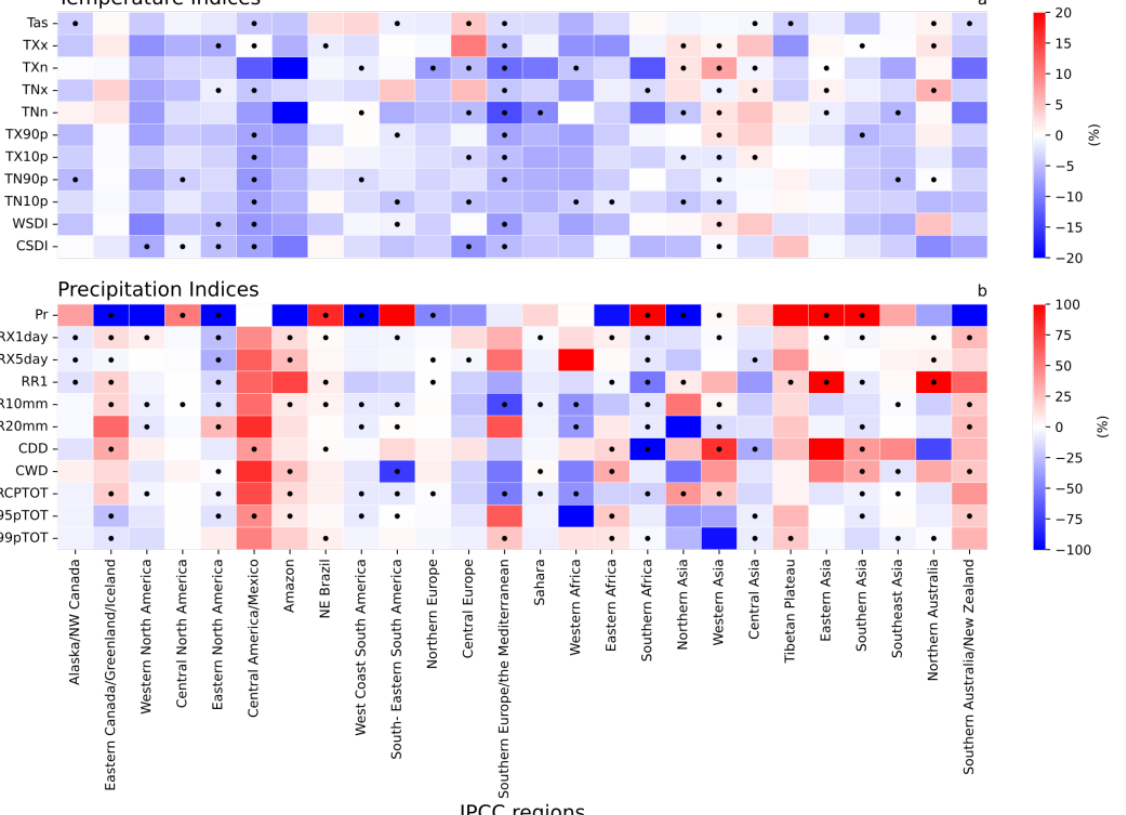
Figure 3. Under SSP1-2.6 scenario, the multi-model ensemble relative contribution of land use change (i.e., ssp126-ssp370lu − ssp126) to future changes in regional temperature extremes ( a ) and precipita- tion extremes ( b ); relative contributions are calculated relative to future regional projections with all other anthropogenic forcings for each of the extreme climate indices (see Methods). The 26 regions selected are defined by IPCC AR5 Reference Regions (Supplementary Materials Figure S4). A black dot is added when at least 80% of models simulate the same change sign in the region.